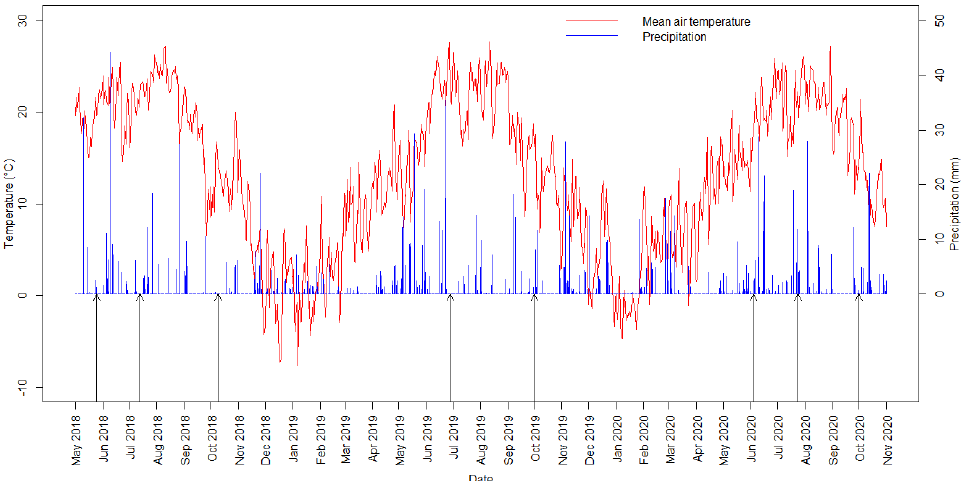
Figure 3. Daily averages of air temperature and daily sums of precipitation during the study period with the measuring days (black arrows), spring 2018–autumn 2020, at the Fülöpháza site. Table 2. Averages of air temperature, sums of precipitation and averages of global radiation at the measuring campaigns and 3d before them. Campaigns Average of air Sum of precipitation Average of global temperature ( ◦ C) (mm) radiation (Wm 2 ) 3d before Measuring day 3d before Measuring day 3d before Measuring day Spring 2018 20.66 19.63